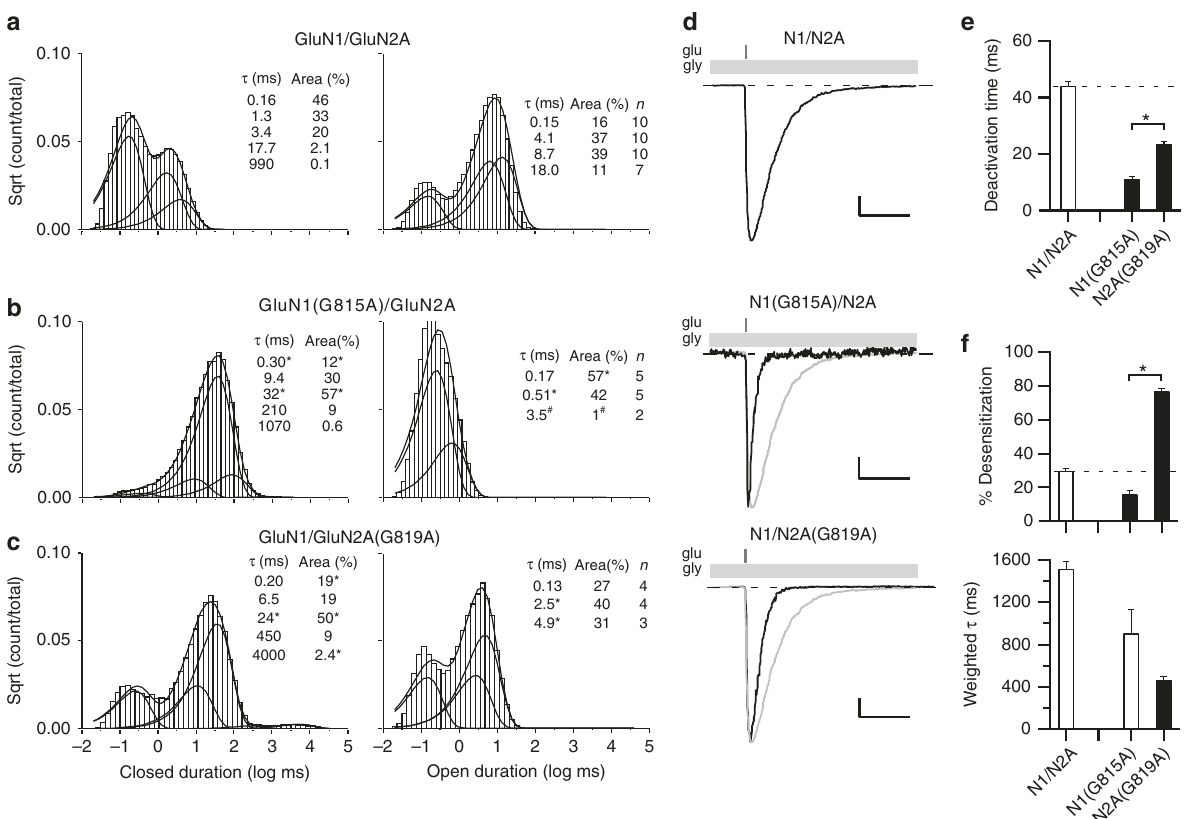
Fig. 6 Constraining the conserved glycine prevents entry into long-lived open states and speeds deactivation. a – c Closed (left) and open (right) time histograms for wild type ( a ) or for receptors containing an alanine substitution at the conserved glycine in GluN1 ( b ) or GluN2A ( c ). All closed time histograms were best fi t with 5 exponentials (Supplementary Table 5), whereas open time histograms were best fi t typically with 4 (wild type), 2 (GluN1 (G815A)), or 3 (GluN2A(G819A)) exponentials (Supplementary Table 6) (see Methods). Smooth lines are associated exponential fi ts. Insets, mean closed and open state durations ( τ , ms), occupancies ( α , %), and for open time distributions how many recordings contained that open time (Supplementary Tables 5 & 6). For GluN1(G815A), the longest-lived open state (3.5 ms) was identi fi ed in only 2 out of 5 recordings; # indicates that we did not do statistics on this state. d Whole-cell currents in response to a 2 ms application of glutamate (1 mM, gray bars) applied in the continuous presence of glycine (light gray bars). Recordings were made and analyzed as in Fig. 2a but included extracellular 0.05 mM EDTA to remove effects of Zn 2 + as done for single channel recordings. Scale bars: 300 pA, wild type; 10 pA, N1(G815A); 100 pA, N2A(G819A); time base is 100 ms for all. e , f Mean± SEM ( n > 5) showing deactivation rates ( e ) or desensitization properties ( f ) for constructs shown in d . Solid bars indicate values signi fi cantly different from wild type, whereas asterisks indicate values different from each other ( p < 0.05,